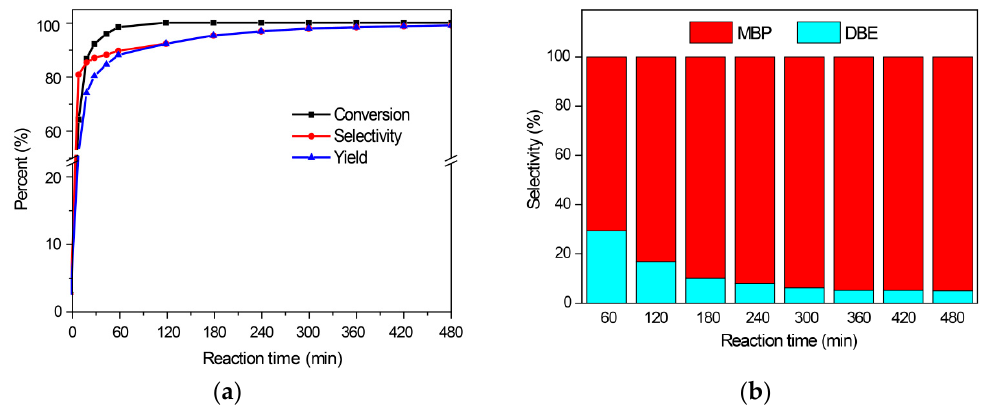
Figure 8. Benzylation of mesitylene and benzyl alcohol at 373 K. ( a ) Conversion (based on benzyl alcohol), selectivity and yield (referred to diphenylmethane) ( b ) Product distribution of mono benzylation products (MBP, 2-benzyl-1,3,5-trimethylbenzene in this case) and DBE.